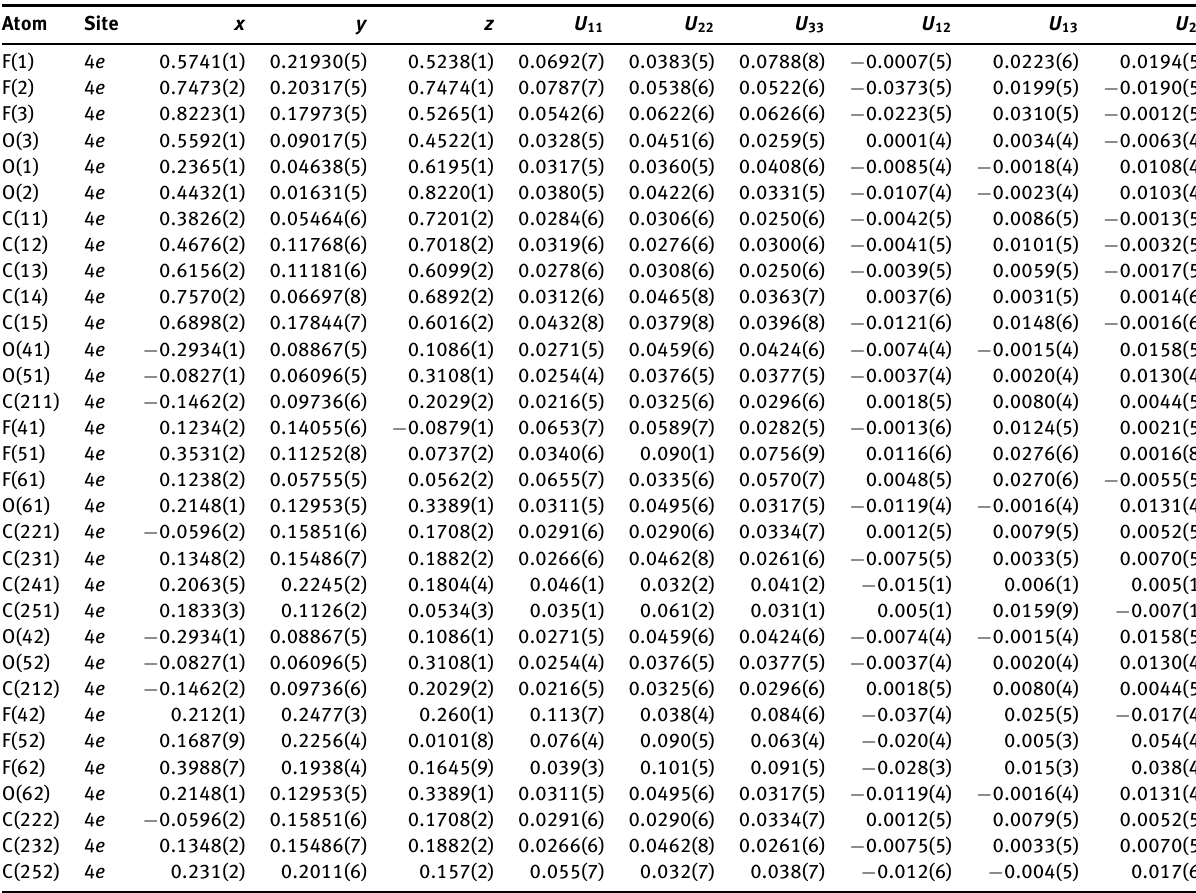
Table 3: Atomic displacement parameters (Å 2